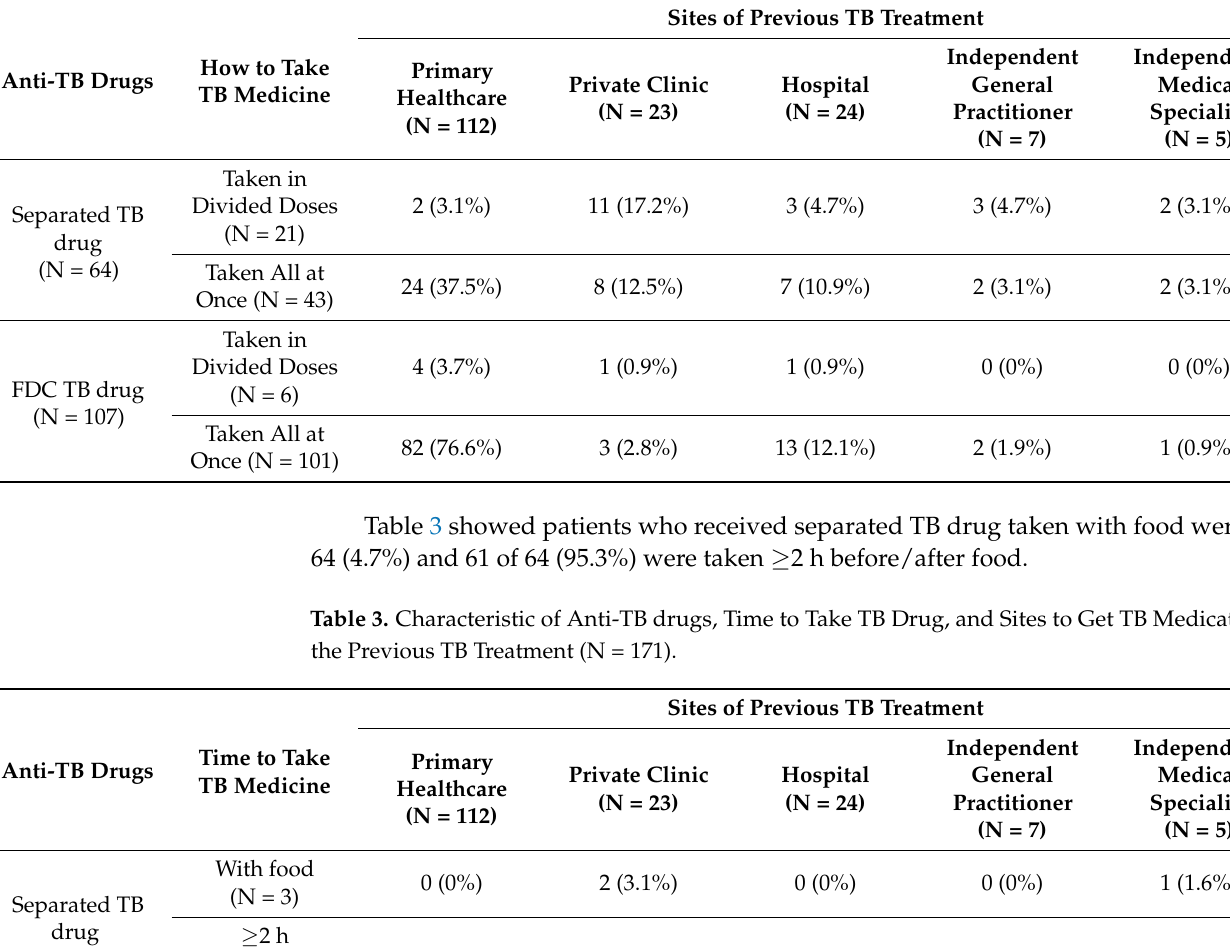
Table 2. Characteristic of Anti-TB drug, How to Take TB Drug, and Sites to Get Medication in the Previous TB Treatment (N = 171).